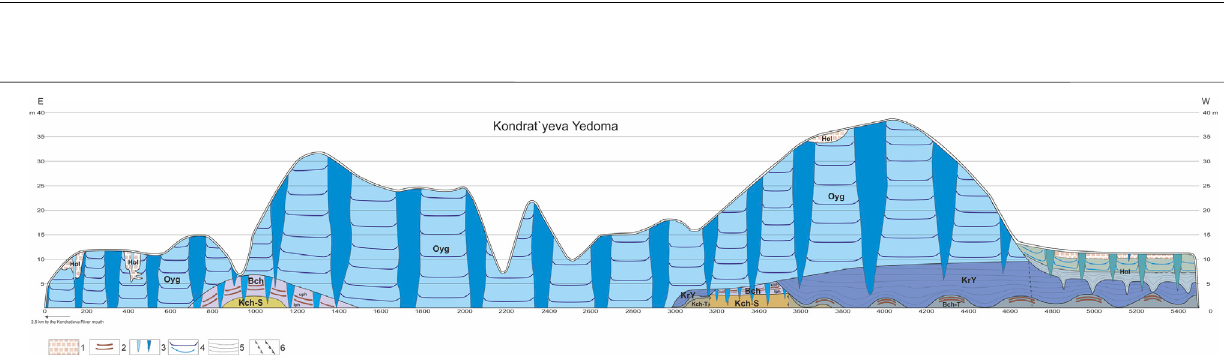
Frontiers in Earth Science |